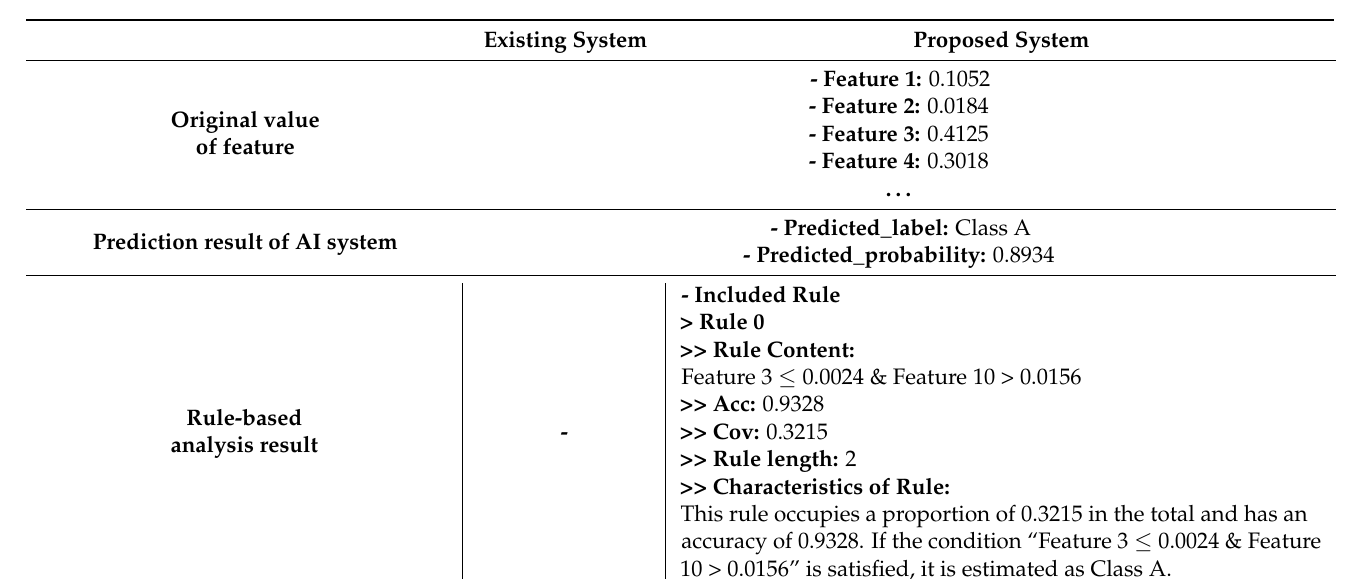
Table 2. Comparison of the key characteristics of the existing and proposed models. It provides information necessary for analysis by adding descriptions that are lacking in existing